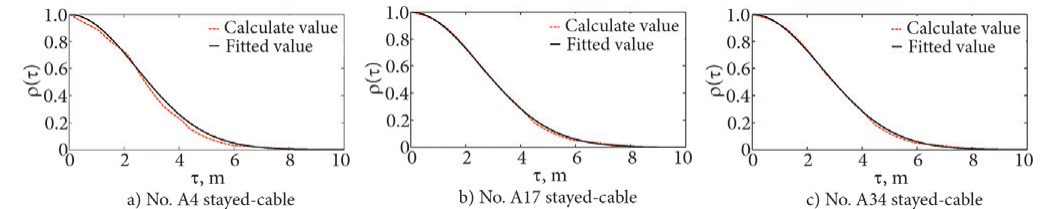
Fig. 8. Curves fitting of auto-correlation for cable stress under random vehicle load